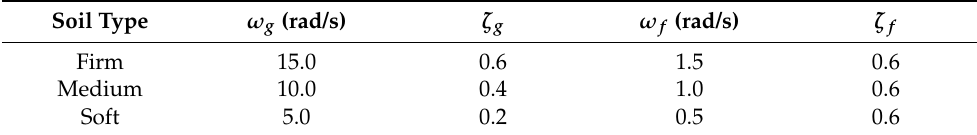
Table 3. The parameters of the Clough–Penzien model for different soil